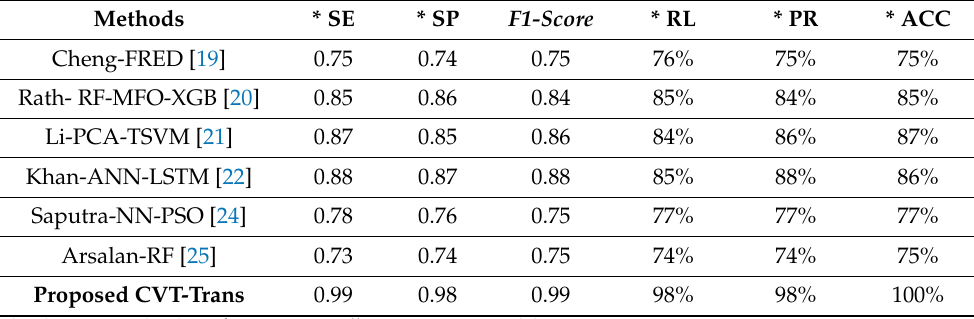
Figure 11. The ROC and AUPROC curves for proposed CVT-Trans technique for classification of five-categories cardiovascular disease. Table 6. Performance comparisons between proposed method and state-of-the-art techniques by using data augmentation, 10-fold cross validation test and by using two stages of CVD disease. Methods